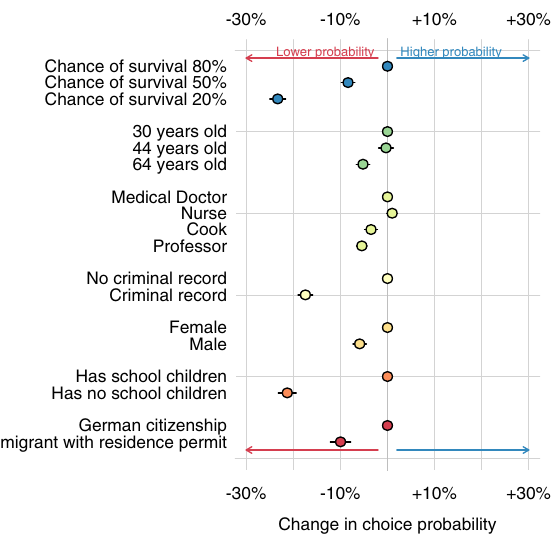
Fig. 1 For each patient attribute, the reference category is listed fi rst and represented at 0 on the x -axis (80% chance of survival, 30 years old, Medical Doctor, No criminal record, Female, Has school-aged children, German citizen). For the other categories, dots (with 95% con fi dence intervals) are the difference in the average marginal component effects (AMCE) between the reference category and the category listed on the y -axis. Pooled survey waves 1 –